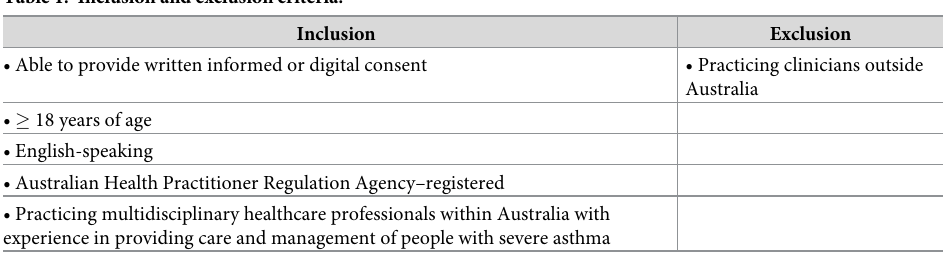
Table 1. Inclusion and exclusion